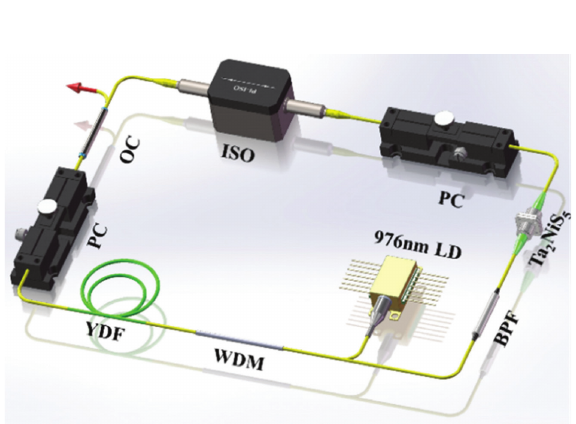
Figure 2: Ultrafast-optical property of Ta Nonlinear optical transmission of SA at (A) 1 μ m and (B) 1.5 μ m.